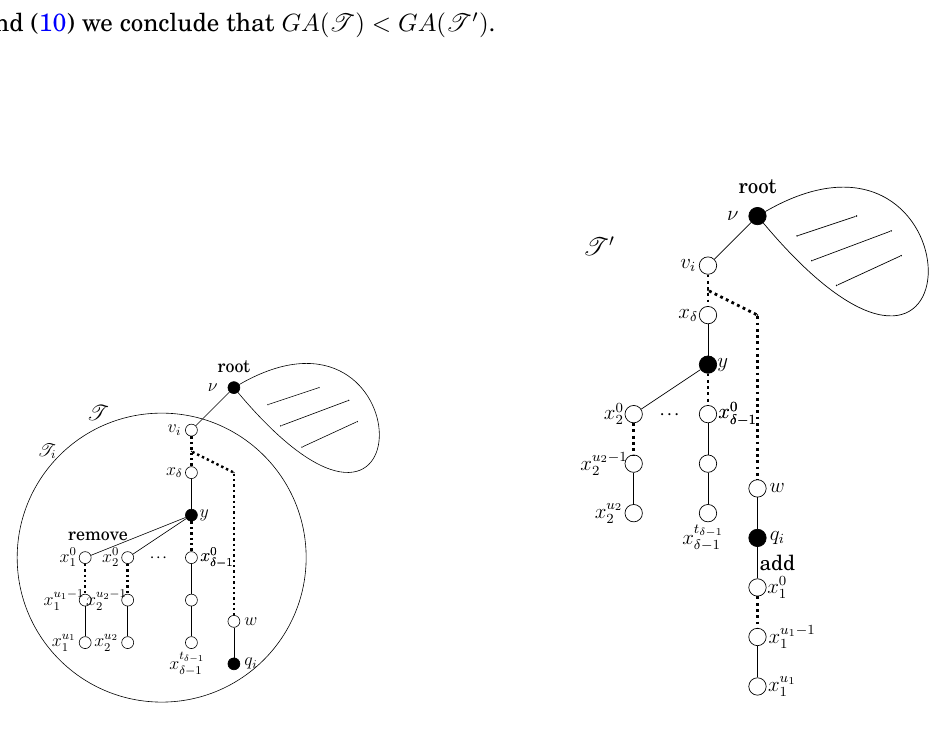
Figure 3: The trees T and T (cid:48) used in the proof of Lemma